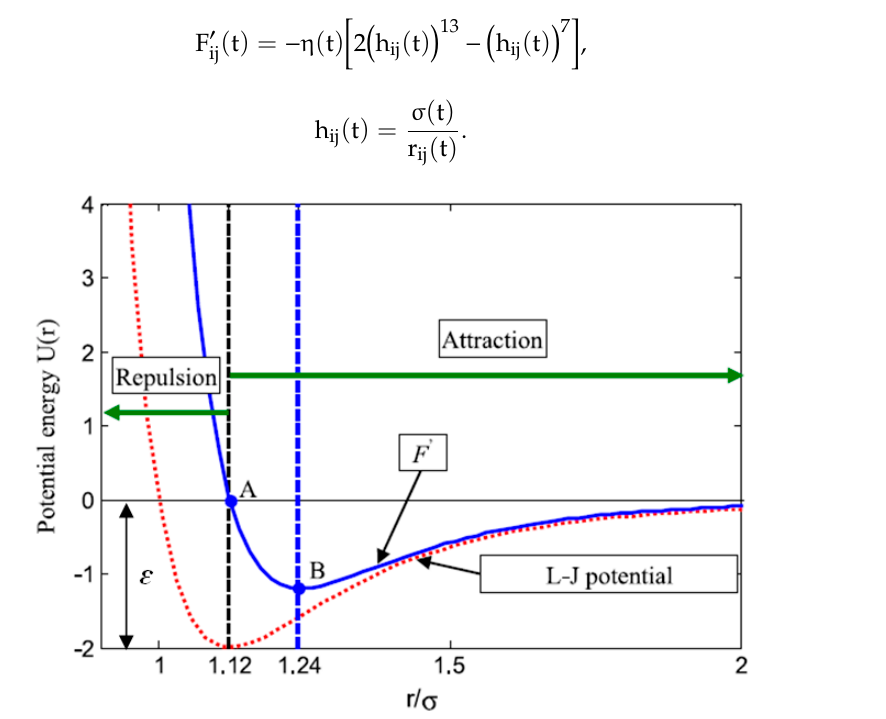
Figure 1. Atoms force against spacing between them [29].